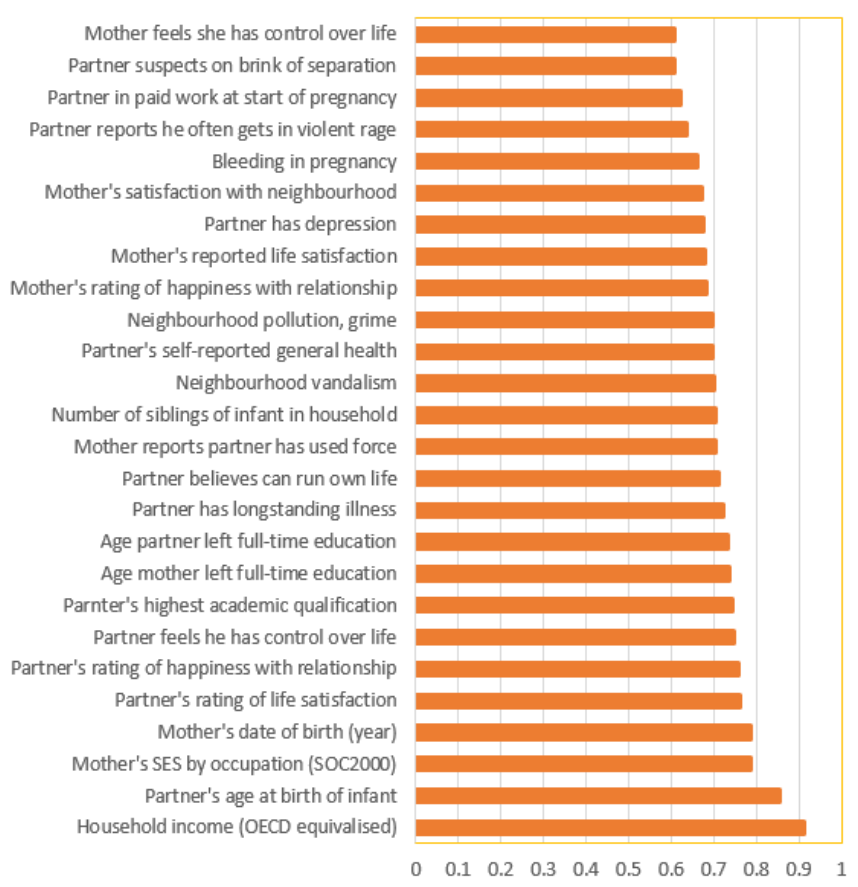
Figure 2. Importance scores for features with average importance scores above 0.6 in 72-feature RF algorithms predicting premature birth before 37 weeks.